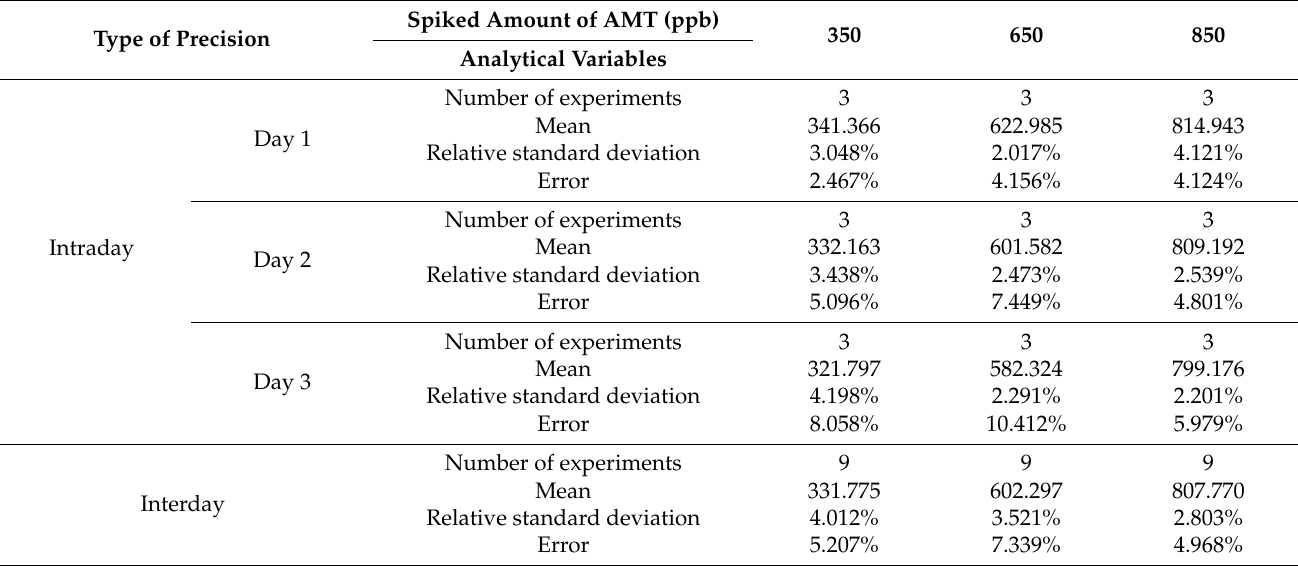
Table 1. Precision and accuracy of controls in